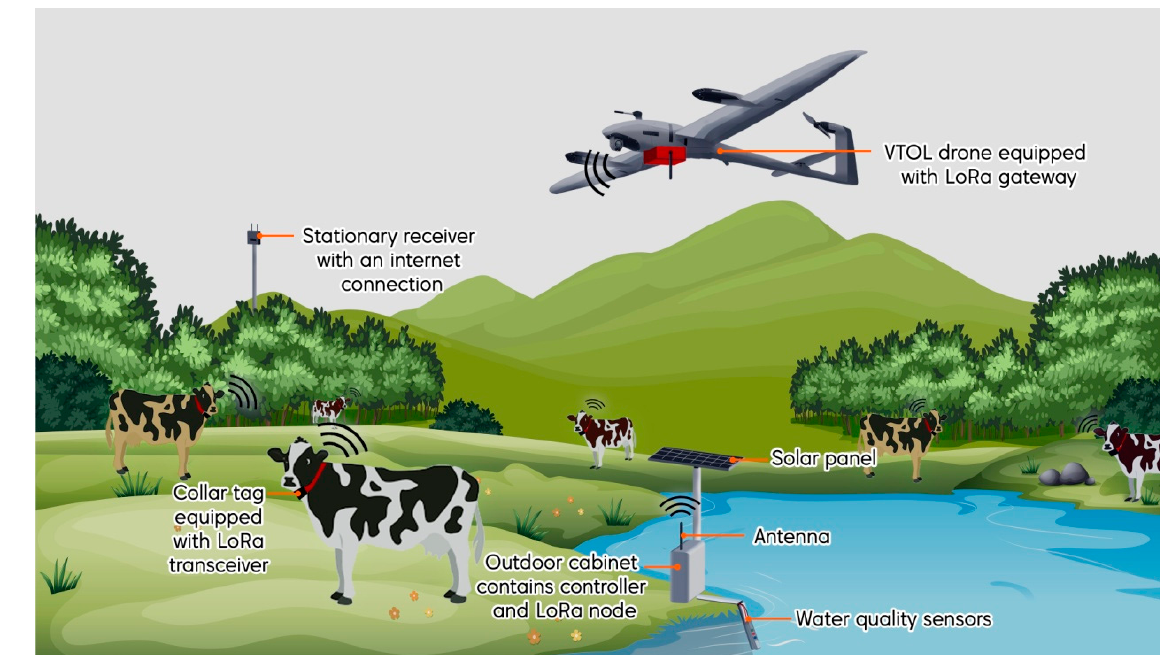
Figure 1. Conceptual design of the developed farm monitoring system.